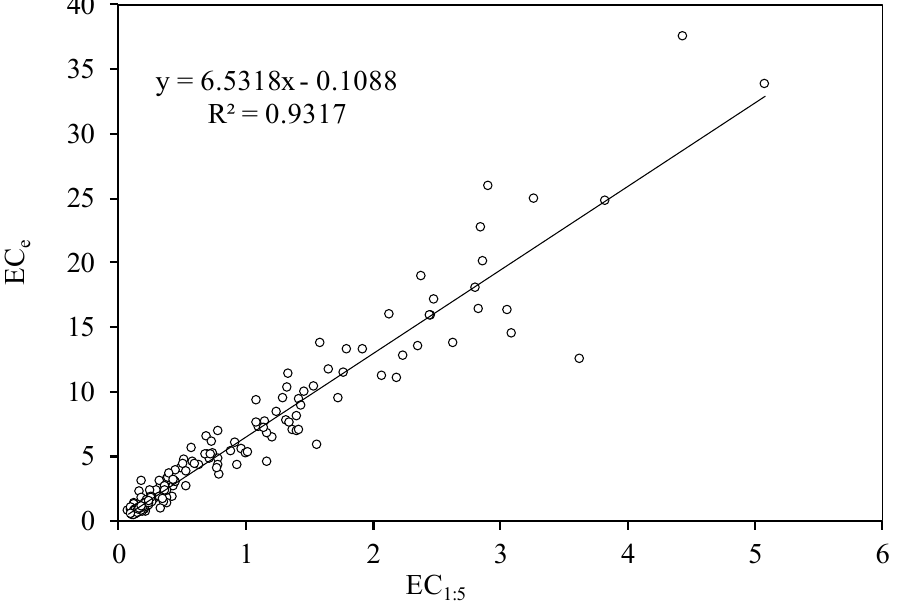
Figure 4. The relationship of EC (dS m − 1 ) as this was measured by the methods for EC e and EC 1:5 for soil samples